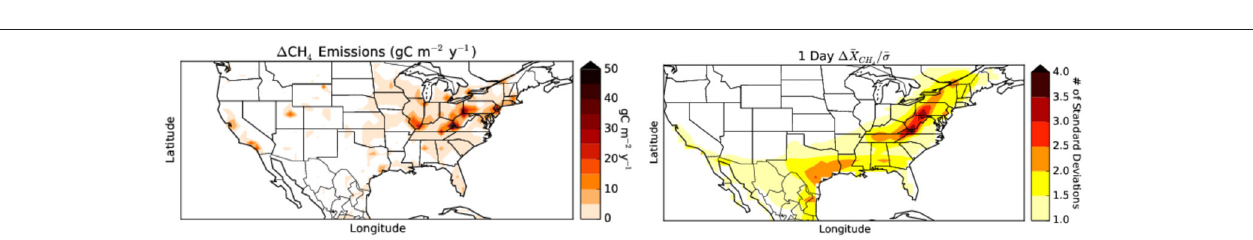
FIGURE 7 | (Left) The emissions difference used for the CONUS fugitive methane experiment, equal to 0.6 times the EDGAR inventory in line with Miller et al. (2013). (Right) The resulting gridded differences in X CH4 as would be seen from a single GeoCarb daily scan after 30 days of transport, averaged over 100km and scaled by the uncertainty. The role of atmospheric transport is evident in the figure, as the spatial signatures are diffused by the